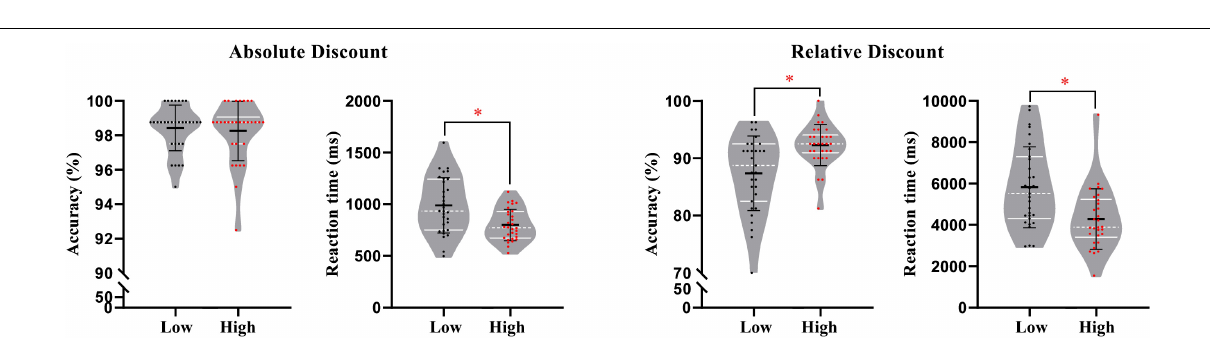
FIGURE 2 | ROIs in time and time-frequency domain analyses. Nine dotted rectangles were 9 ROI in the time domain analysis. The red dots represented P5 and P7 electrodes with a significant delayed modulation (both p cluster < 0.05) in the absolute discount; and the blue dots represented P6, P8, and PO8 electrodes with a significant delayed modulation (both p cluster < 0.05) in the relative discount in time-frequency domain analysis.